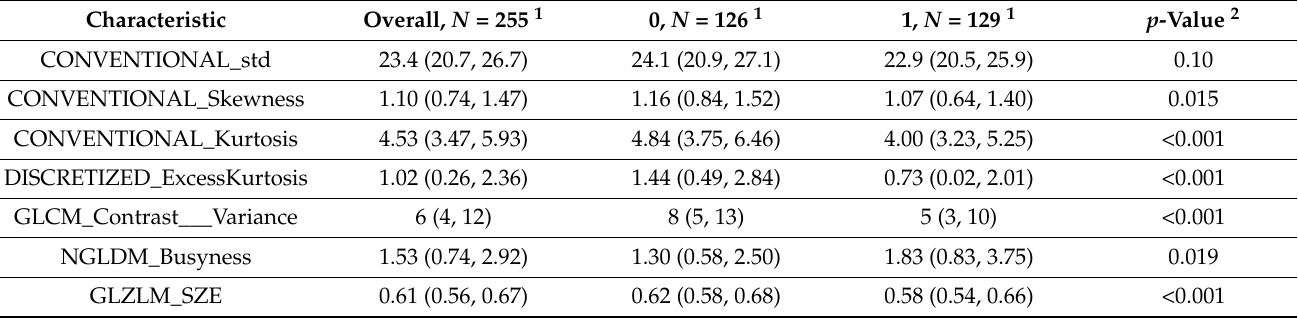
Table 2. Univariate association between the selected radiomic features and prediction of malignancy.